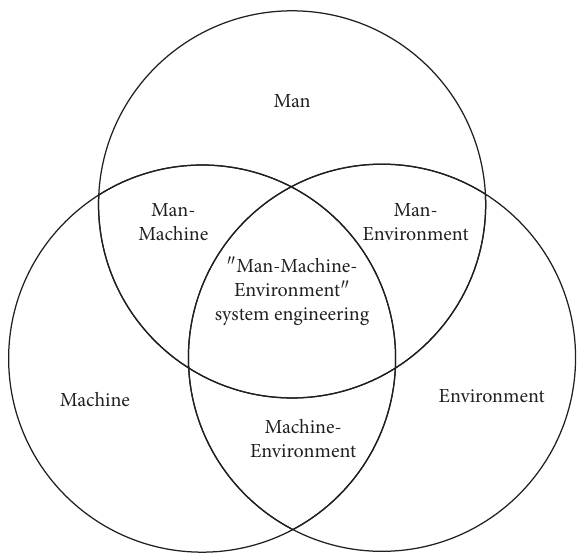
Figure 1: Schematic diagram of the relationship among human, machine, and environment. Table 1: MMESE talent growth factor index